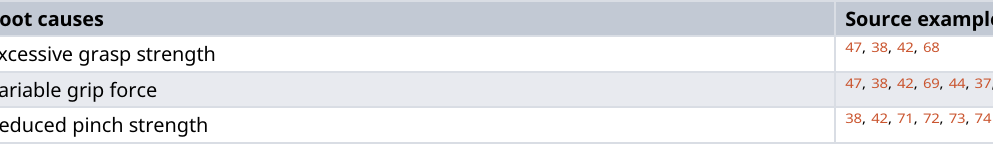
Table 1. Literature citation for cause-and-effect chain root